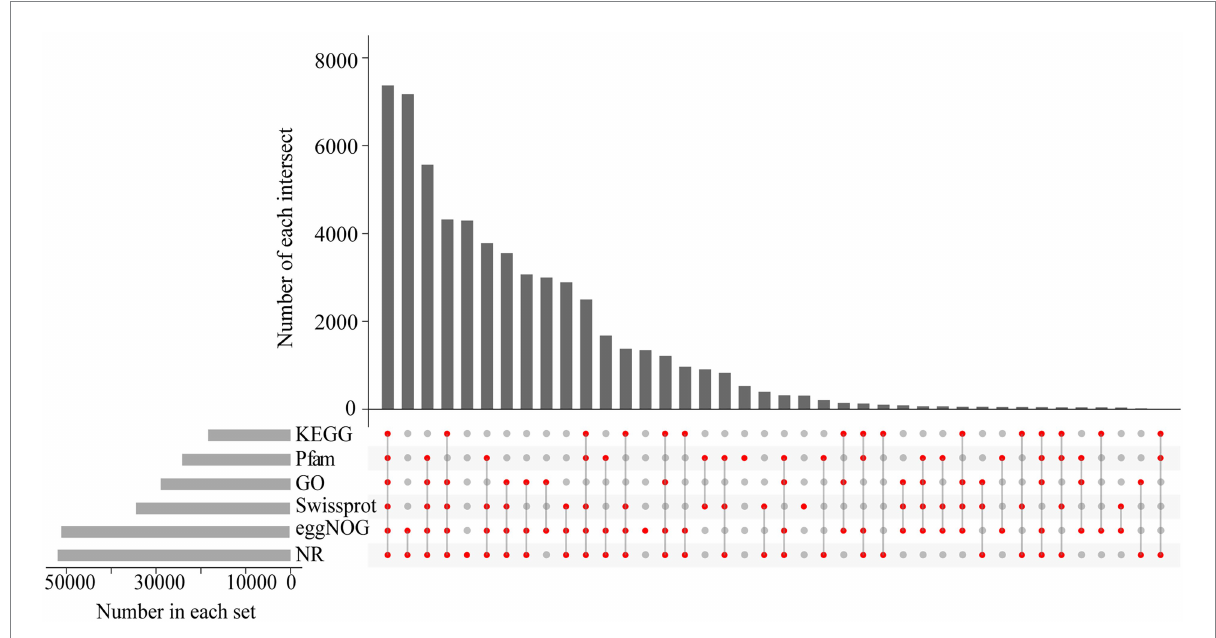
FIGURE 5 The unigenes homology searches against the protein